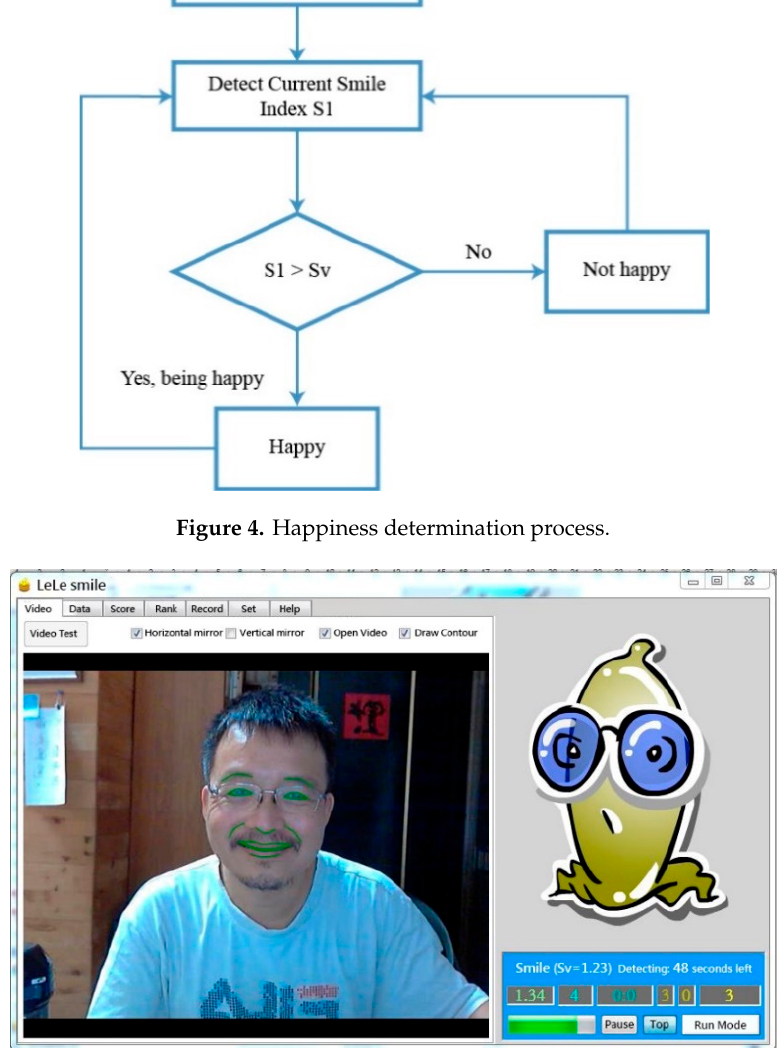
Figure 5. Image in which a smile is detected.